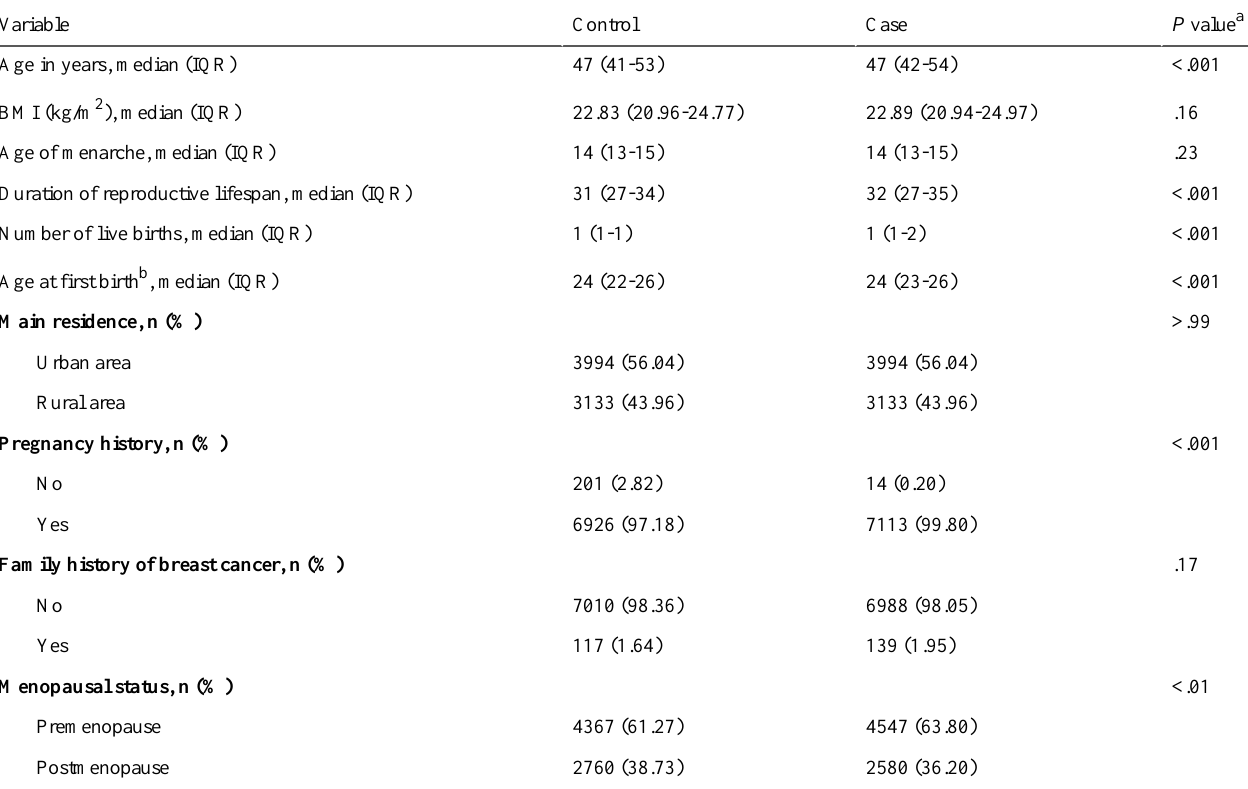
Table 2. Characteristics of case and control